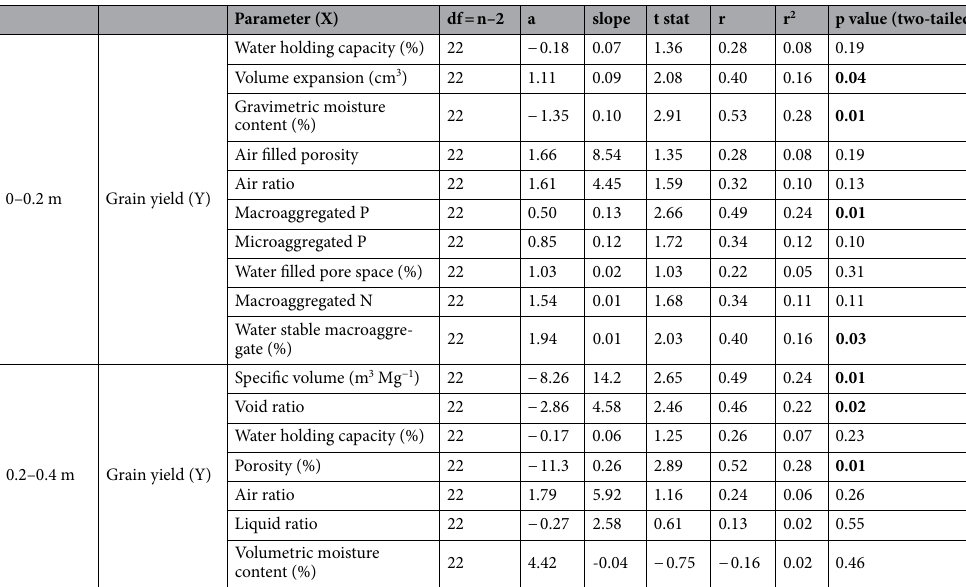
Table 6. Bivariate regression model on wheat grain yield (t ha −1 ) and soil constituents. Significant values are in [bold]. Significant ( p < 0.05,